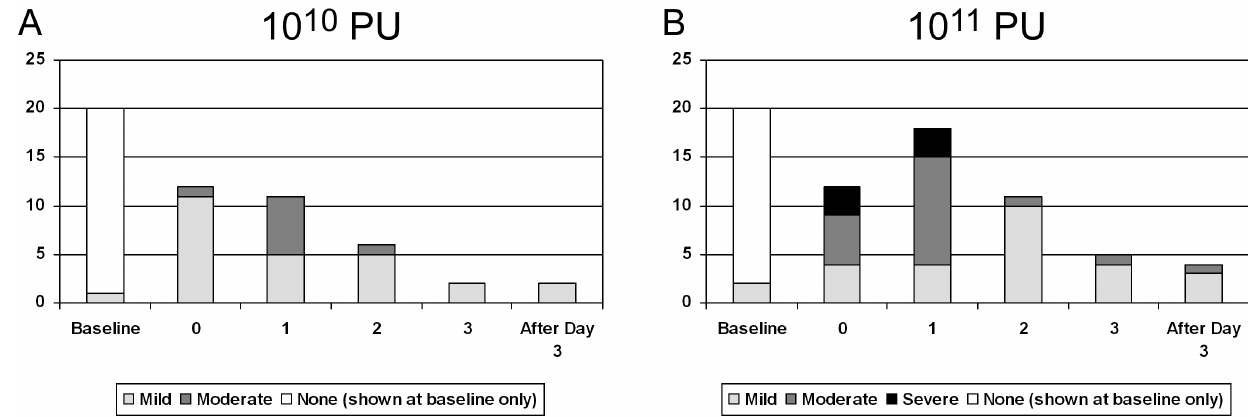
Figure 2. Duration and intensity of systemic reactogenicity. Number of vaccine recipients experiencing each level of severity in one or more systemic symptoms (malaise and/or fatigue, myalgia, headache, nausea, vomiting, chills, or arthralgia) is shown at baseline and for each day of the reactogenicity period. Panel A: 10 10 PU dose; Panel B: 10 11 PU dose. Only the most severe symptom level for each individual on each day is included.